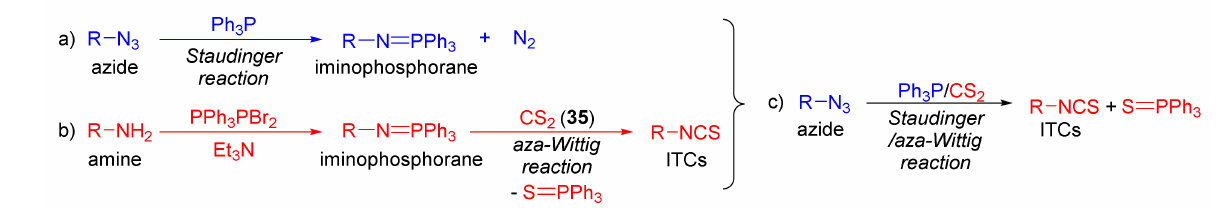
Figure 13. ITCs synthesis via Staudinger/aza-Wittig